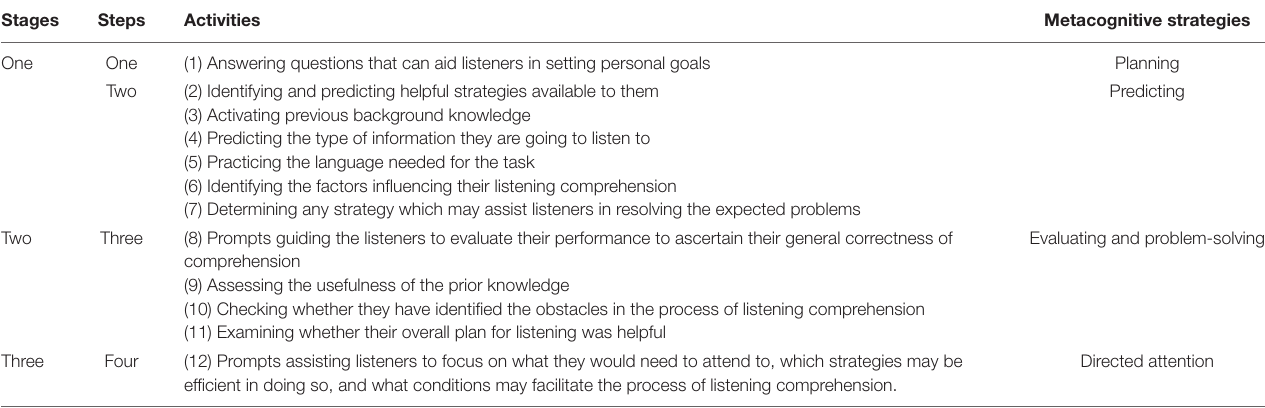
TABLE 1 | Three stages of metacognitive intervention (MI) for listening